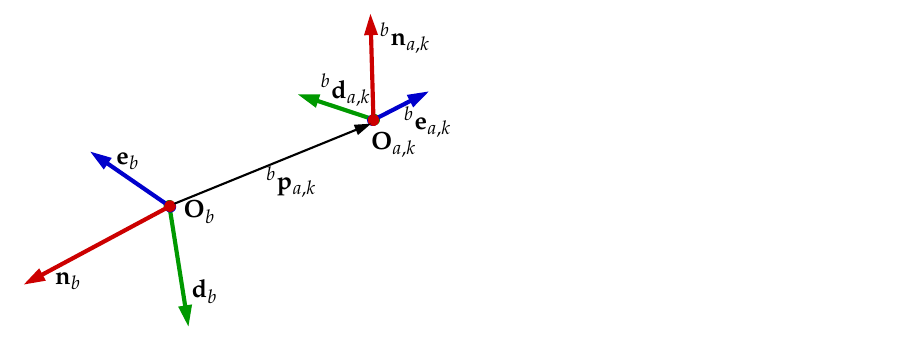
Figure 5. The representation of the frame of any k -th actuator with respect to the body frame { b } of the